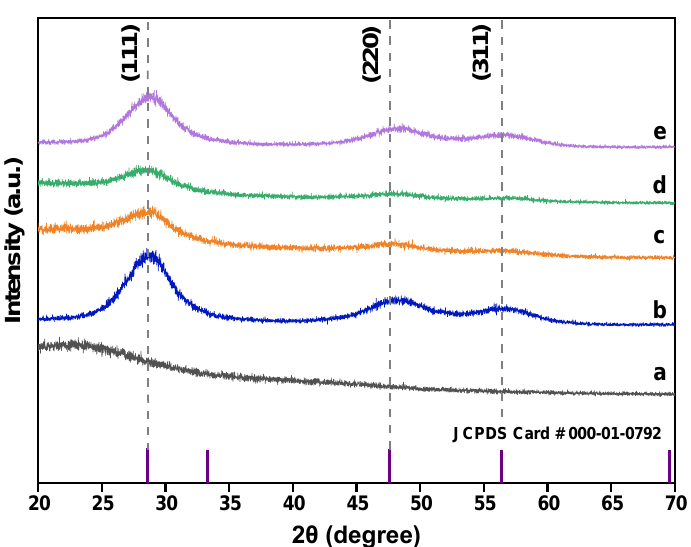
Figure 5. Comparison of XRD patterns for ( a ) CS NPs, ( b ) ZnS, ( c ) Mn:ZnS, ( d ) CS-Mn:ZnS, and ( e ) MMC@CS-Mn:ZnS.